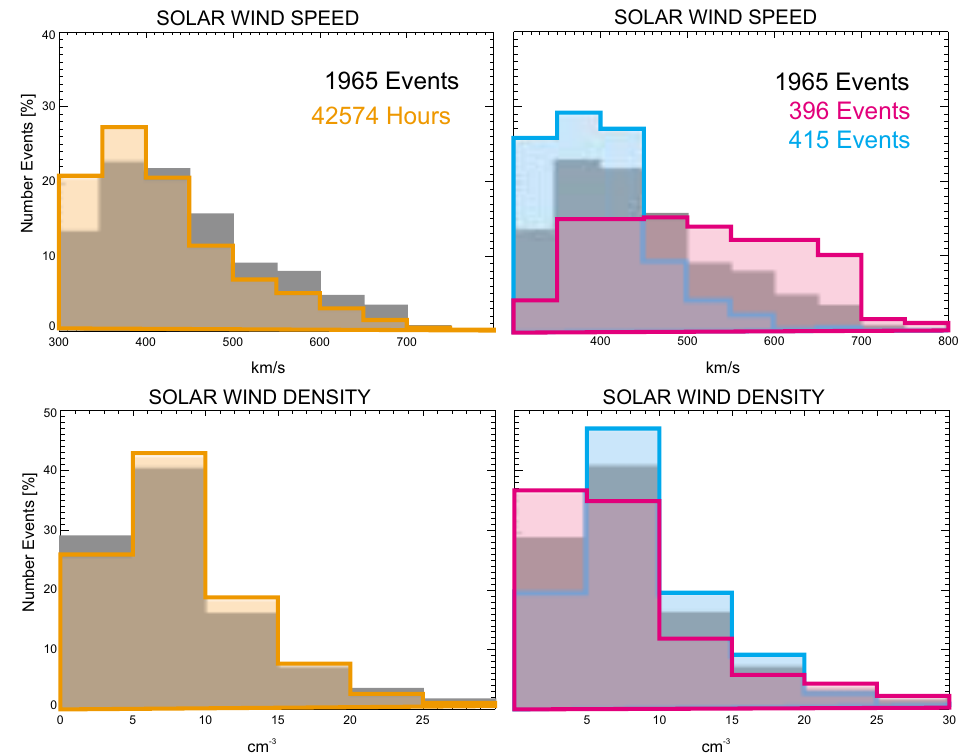
Fig. 15. Relative occurrences as functions of solar wind speed (top panels) and density (bottom panels) at the time of events are displayed. In all panels, the gray block diagrams represent the distributions for all events. For reference, the background distributions for the entire period covered by the analysis (42574h for which OMNI plasma data exist) are displayed in orange in the panels on the left. Panels on the right display the separate distributions for the large (magenta) and small (cyan) amplitude subgroups of